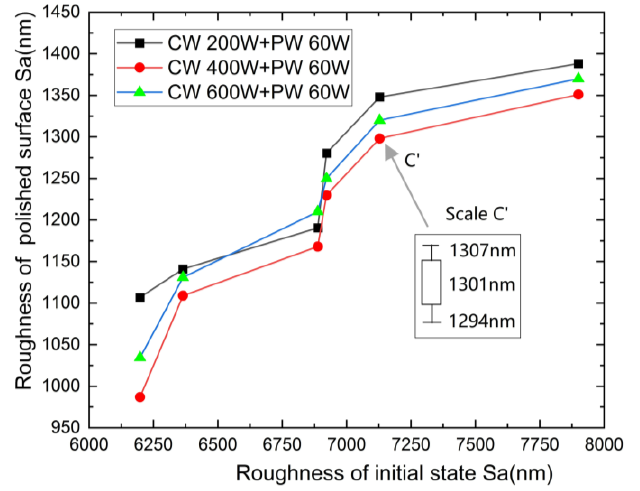
Figure 10. Polished roughness related to initial roughness.